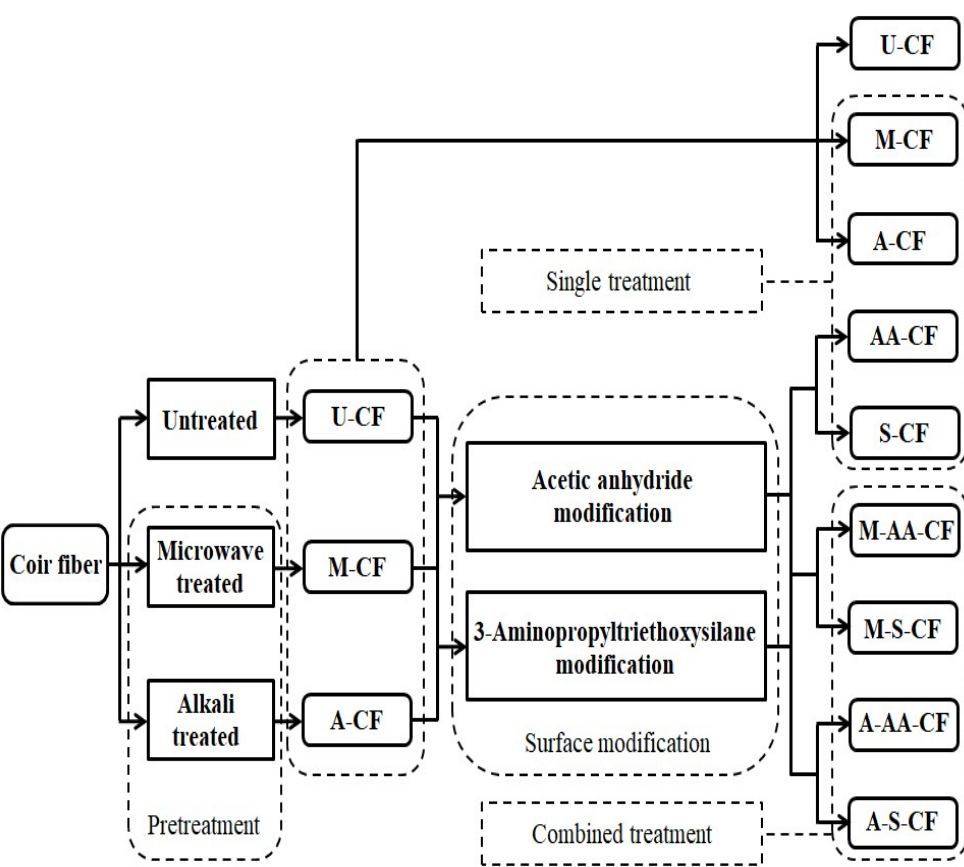
Figure 1. Treatment process of coir fibers.